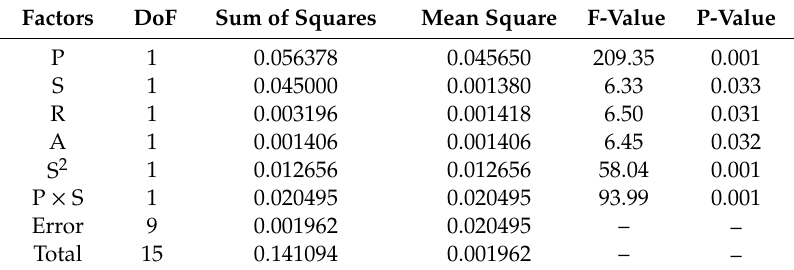
Table 6. ANOVA table for case depth at the root of splines (H R ).